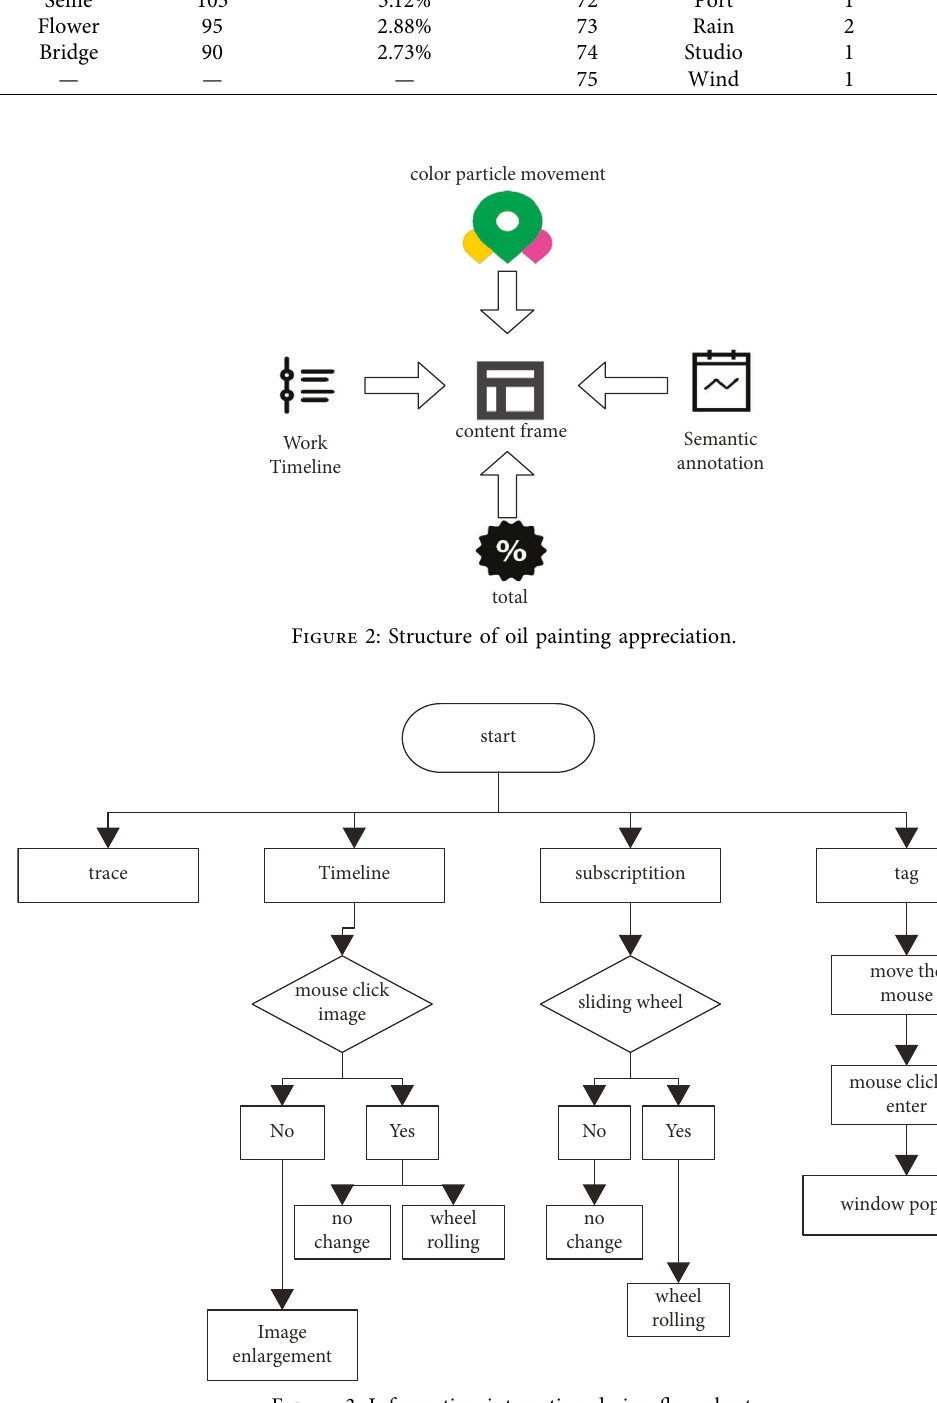
Figure 3: Information interaction design flow